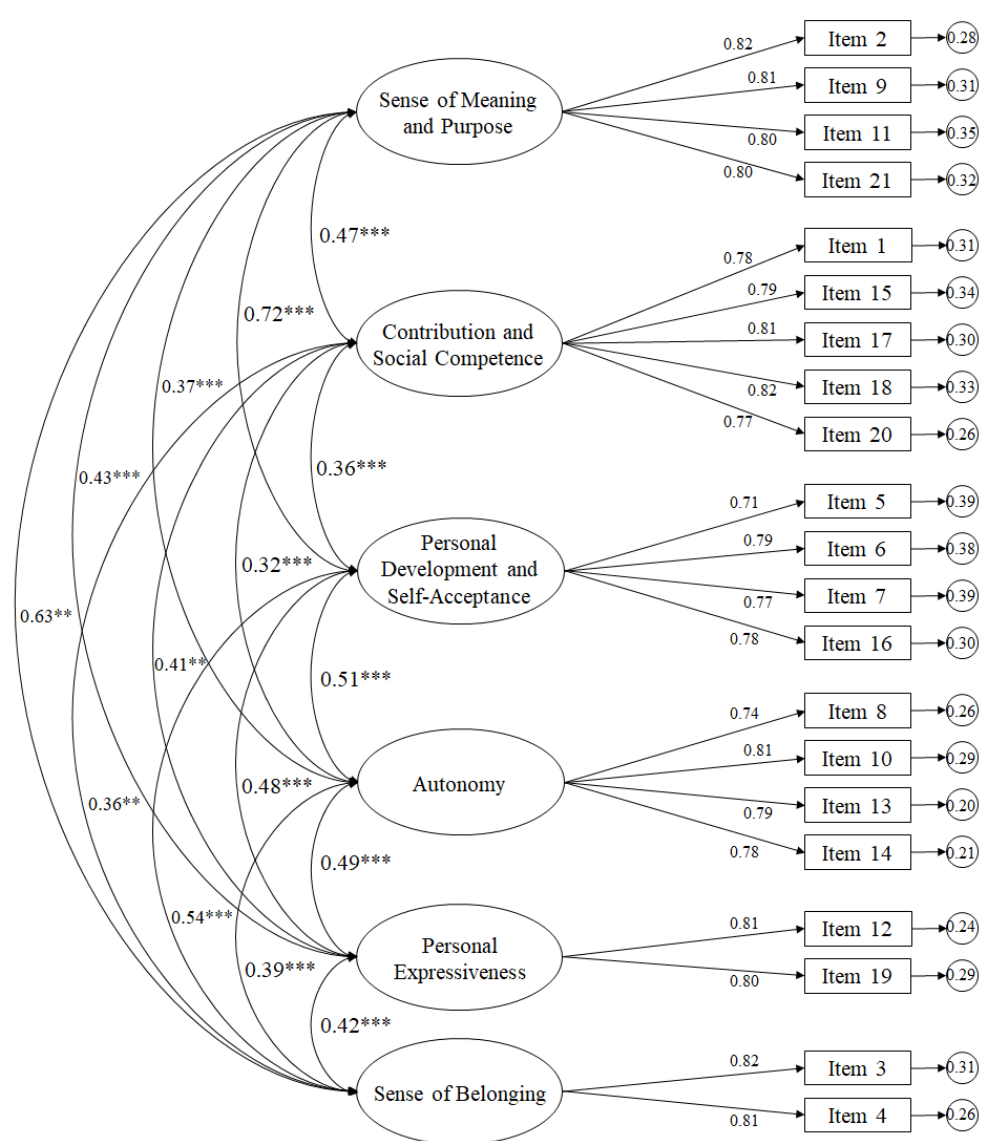
Figure 1. Diagram of the CFA belonging to the Questionnaire on Eudemonic Well-Being in a sport context. *** p < 0.001; ** p < 0.01.